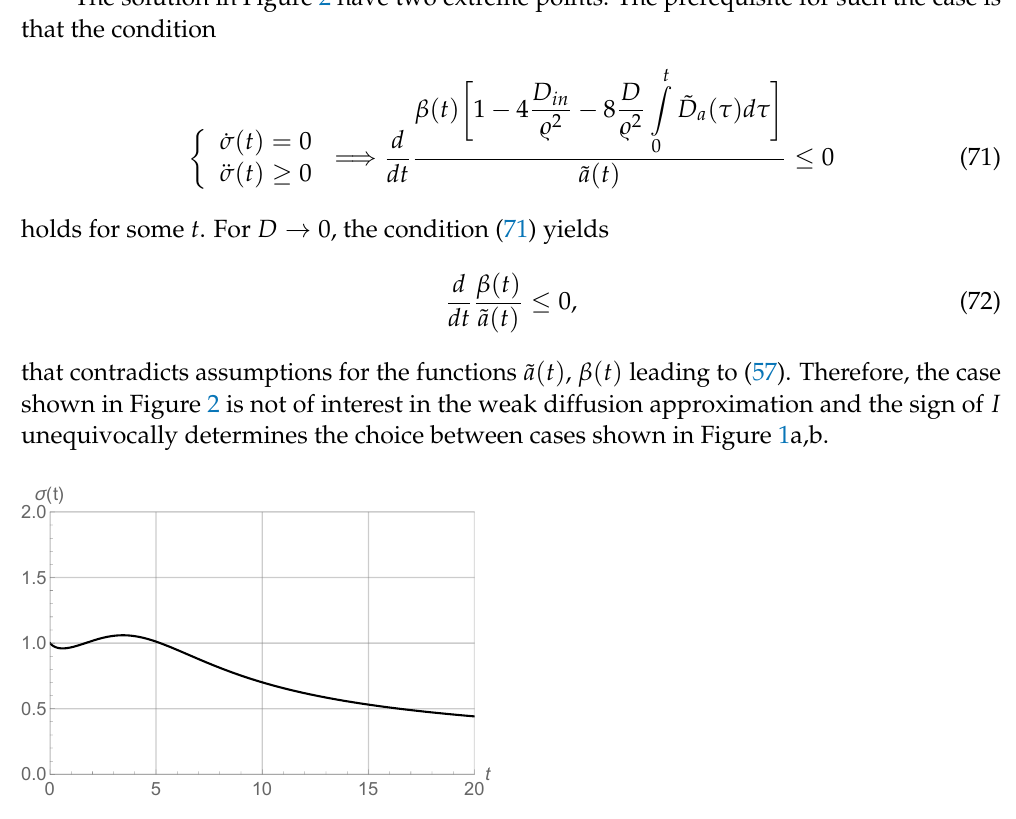
Figure 2. The plot of the function σ ( t ) for the special